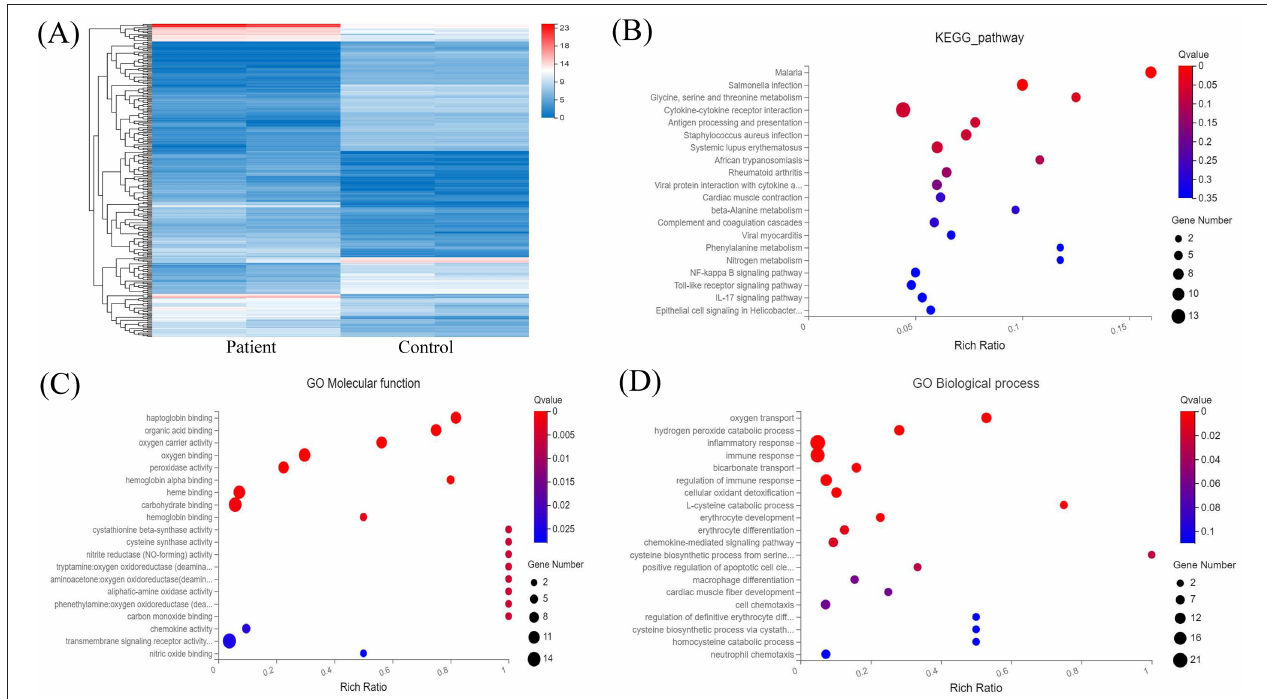
FIGURE 2 | RNA sequencing analysis of the peripheral blood from the patients and normal individuals and functional annotation of mRNAs. (A) Heat map of mRNAs with differential expression in peripheral blood from the patients and normal individuals. (B) KEGG pathway analysis of mRNAs with differential expression. (C,D) GO enrichment analysis of mRNAs with differential